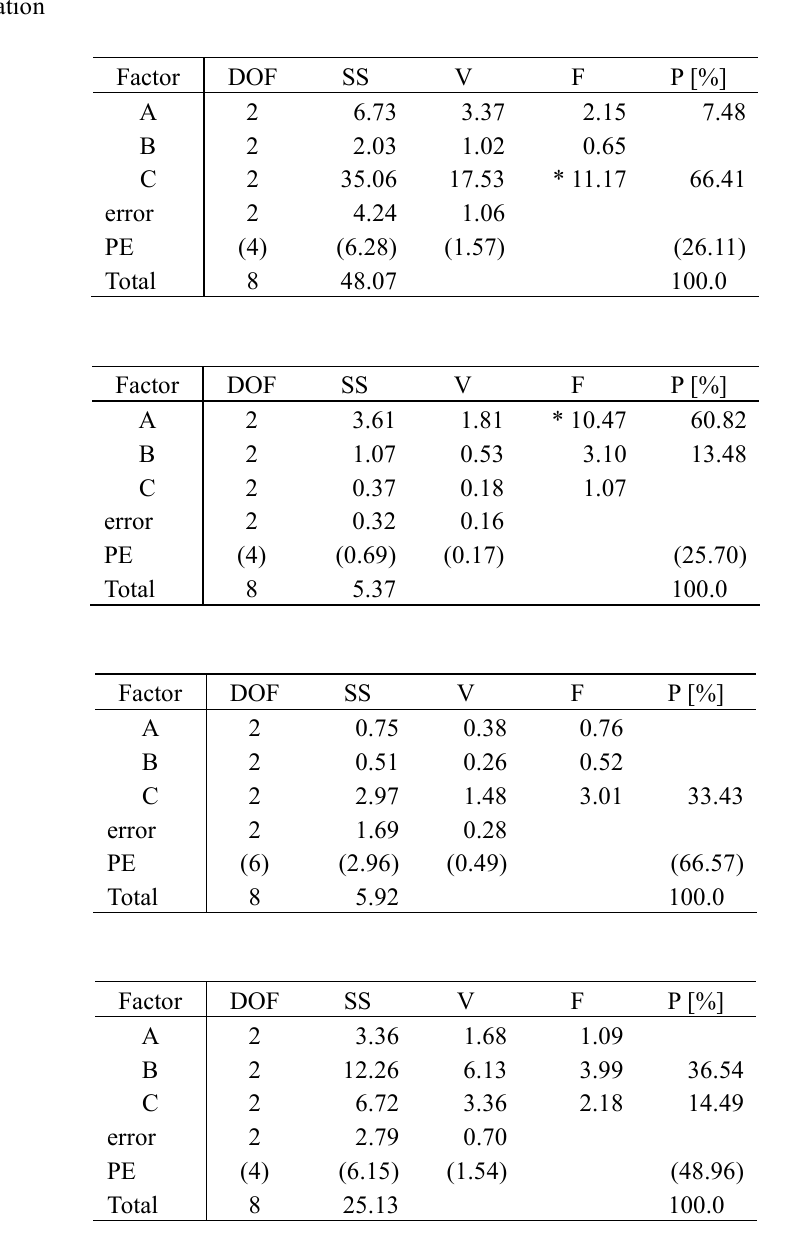
Table 4 ANOVA for (a) the thrust force, (b) torque, (c) temperature increase, and